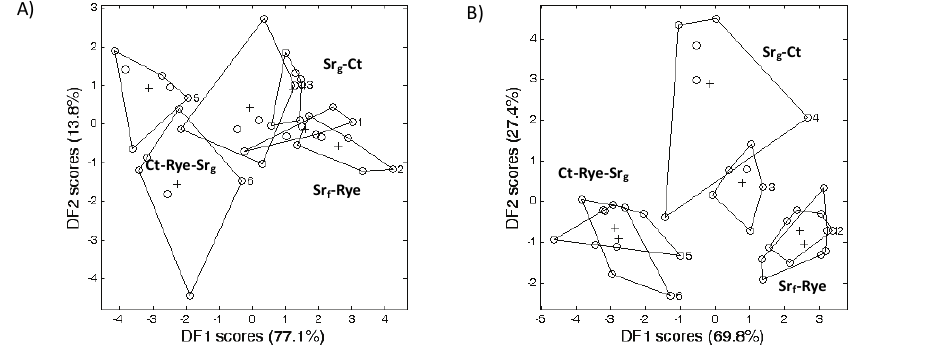
Figure 1. Discriminant function analyses (DFA) comparing bacterial populations among the cropping systems and tillage treatments using two FAME methods: (A) MIDI and (B)